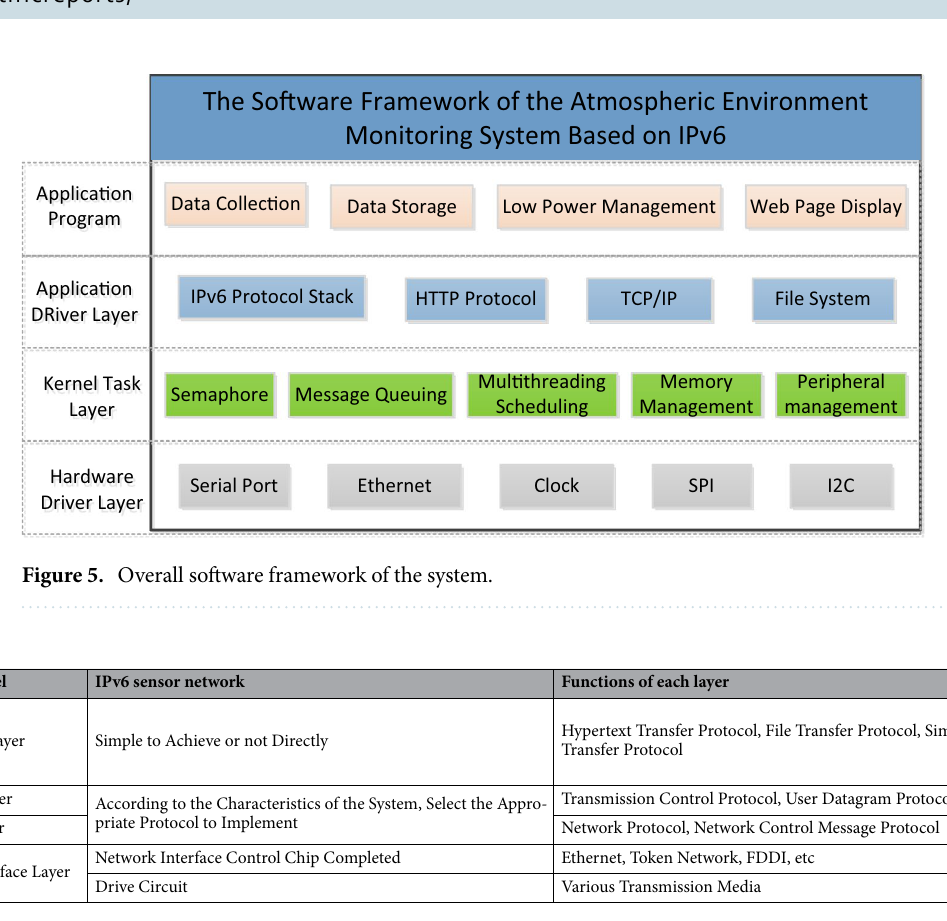
Table 2. Comparison of each layer of the IPv6 sensor network, TCP/IP protocol and OSI